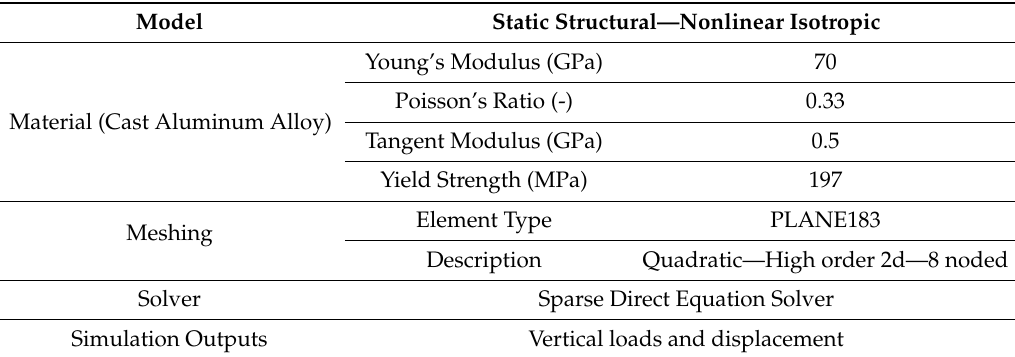
Table 4. Finite element analysis (FEA) inputs details.